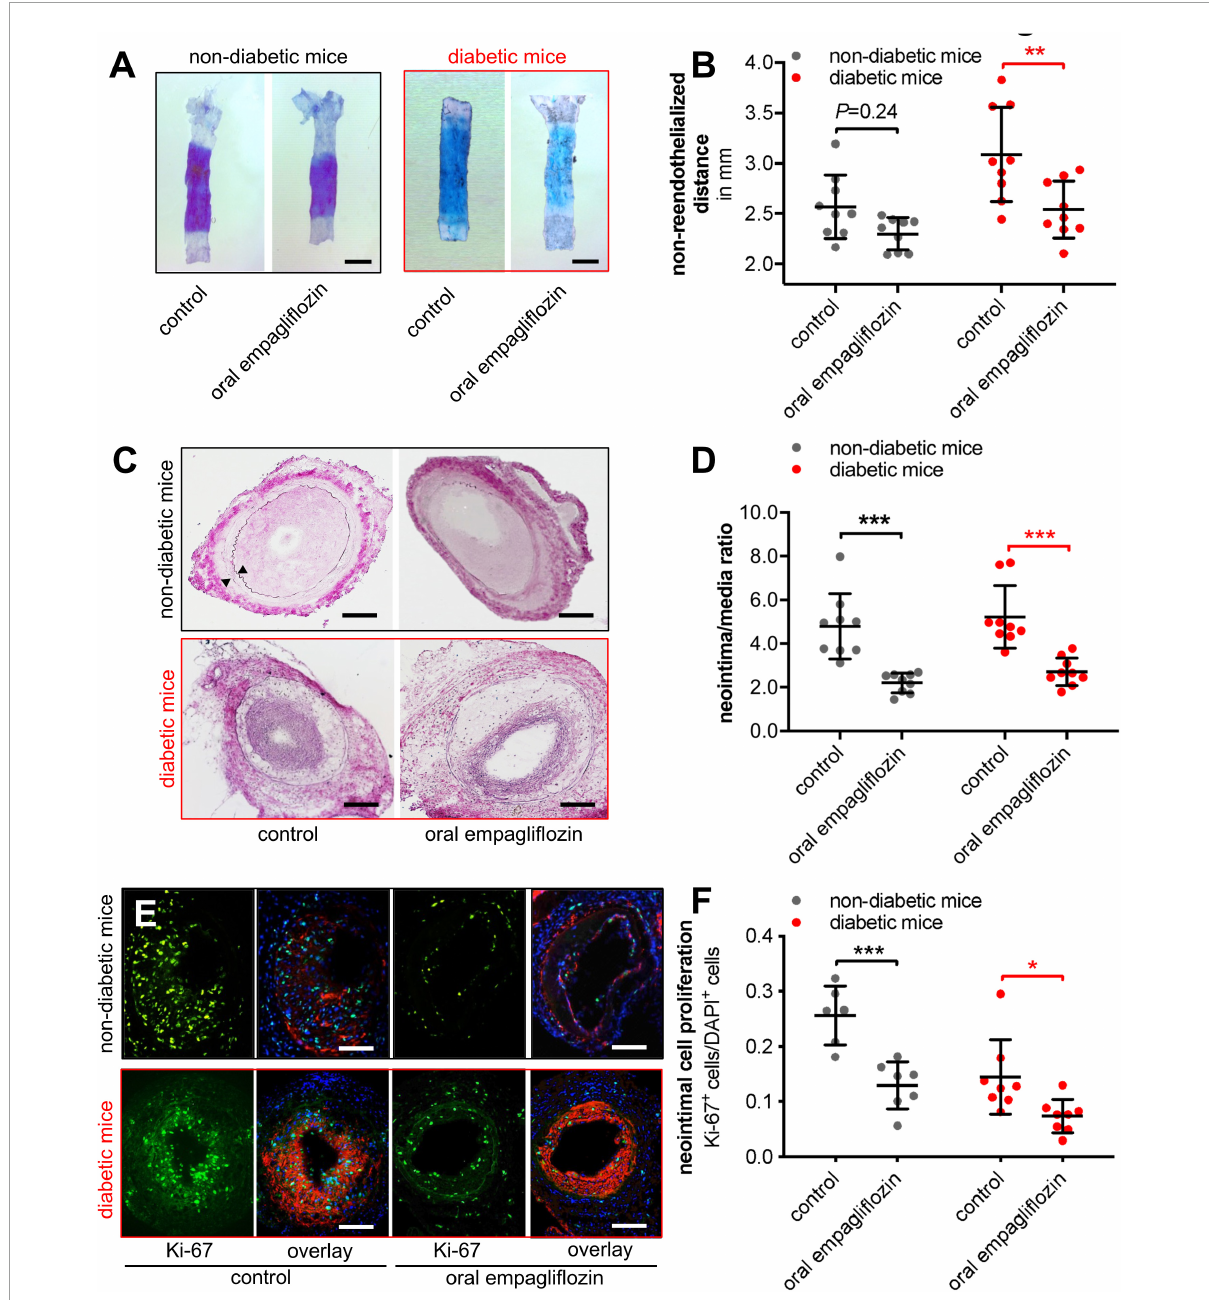
FIGURE3 Empagliflozin improves vascular function in mice. (A,B) Evan’s blue staining at 3 days after electrical injury of the murine carotid artery in non-diabetic and diabetic mice treated with empagliflozin or standard diet ( A , scale bar 1 mm) and quantification of non-re-endothelialized distance ( B , n = 9, ** P < 0.01). (C,D) Verhoeff–Van Gieson staining 21 days following wire-induced injury of non-diabetic and diabetic murine femoral arteries ( C , scale bar 100 µ m, arrowheads mark internal and external elastical laminae) and quantification of neointima/media ratio ( D , n = 9, *** P < 0.0001). (E,F) Neointimal cell proliferation as determined by co-staining for Ki-67 (green), of α -smooth muscle actin (red), and DAPI (blue) at 10 days following wire-induced injury of non-diabetic and diabetic murine femoral arteries ( E , scale bar 100 µ m) and quantification ( F , n = 6–8, * P < 0.05, *** P < 0.001).